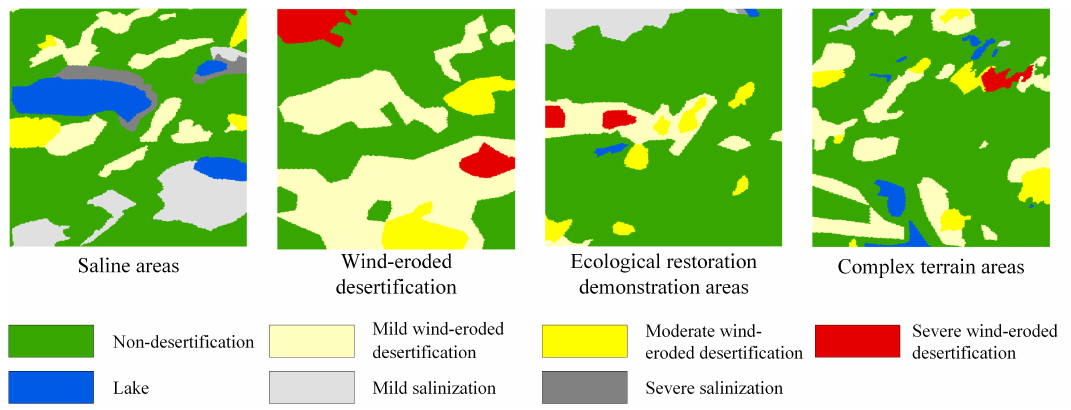
Figure 4. Truth map of four